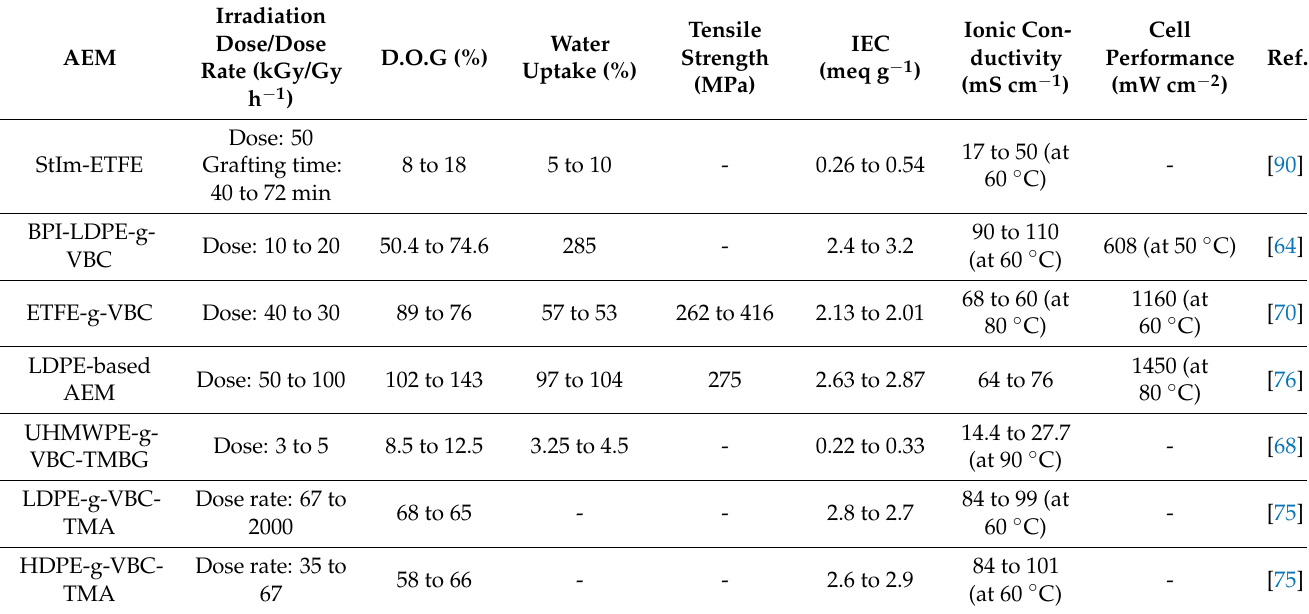
Table 2. Properties of anion exchange membrane (AEM) at a different irradiation dose and dose rate. Irradiation AEM